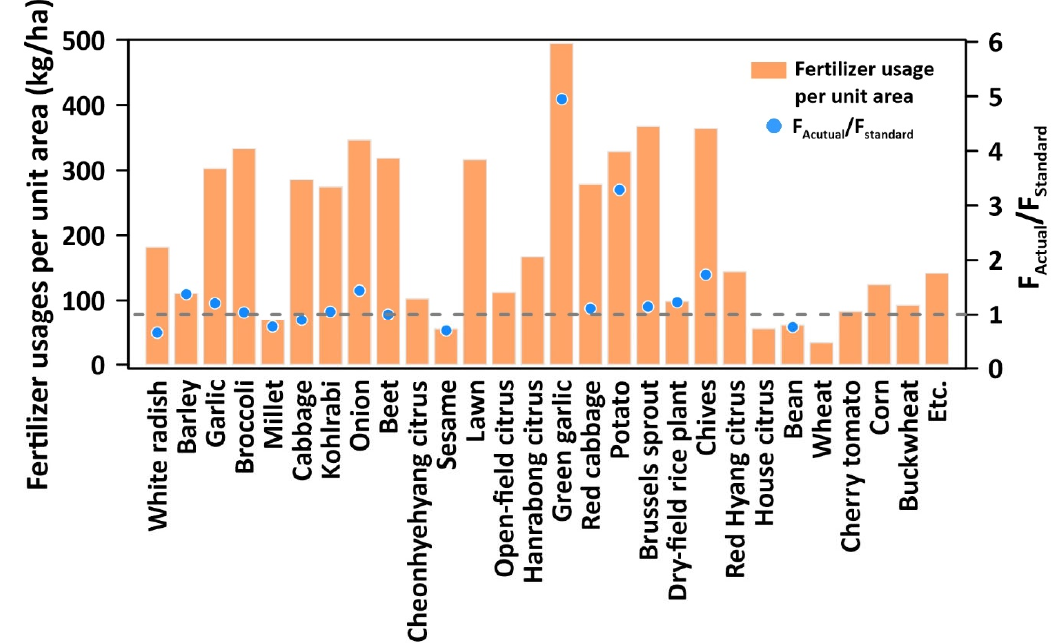
Figure 2. N fertilizer usages per unit area and ratio of actual N fertilizer use divided by standard N fertilizer use (F actual /F standard ).